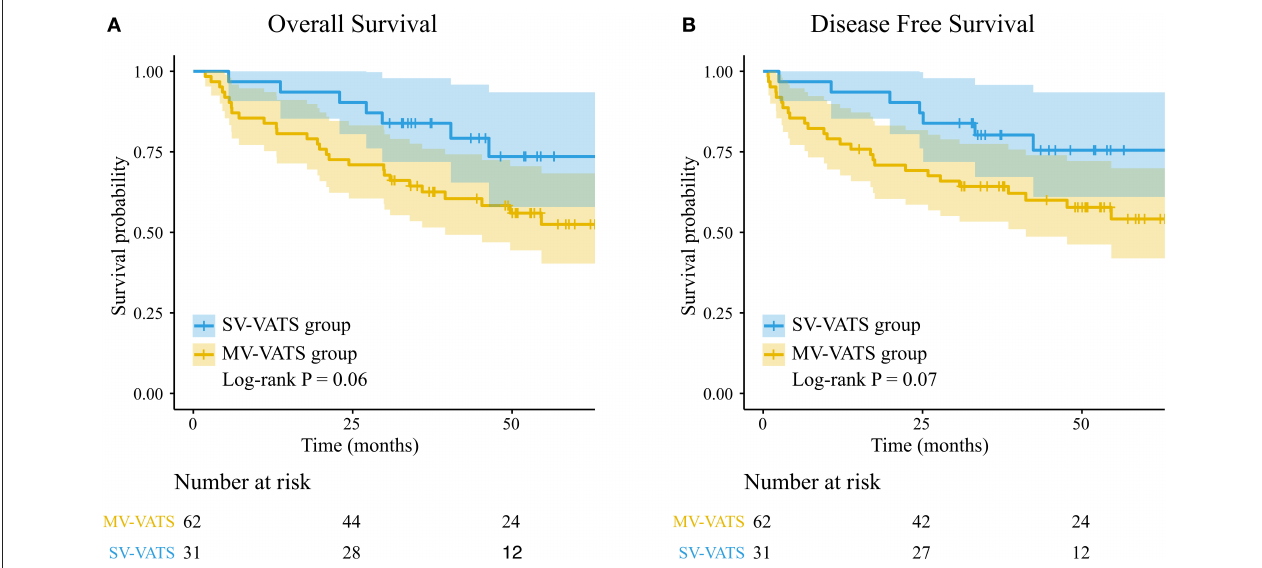
FIGURE 2 | (A) K-M survival curves for overall survival in patients underwent the SV-VATS and MV-VATS. (B) K-M survival curves for disease-free survival underwent the SV-VATS and MV-VATS. K-M, Kaplan–Meier; SV-VATS, spontaneous ventilation video-assisted thoracoscopic surgery; MV-VATS, mechanical ventilation.